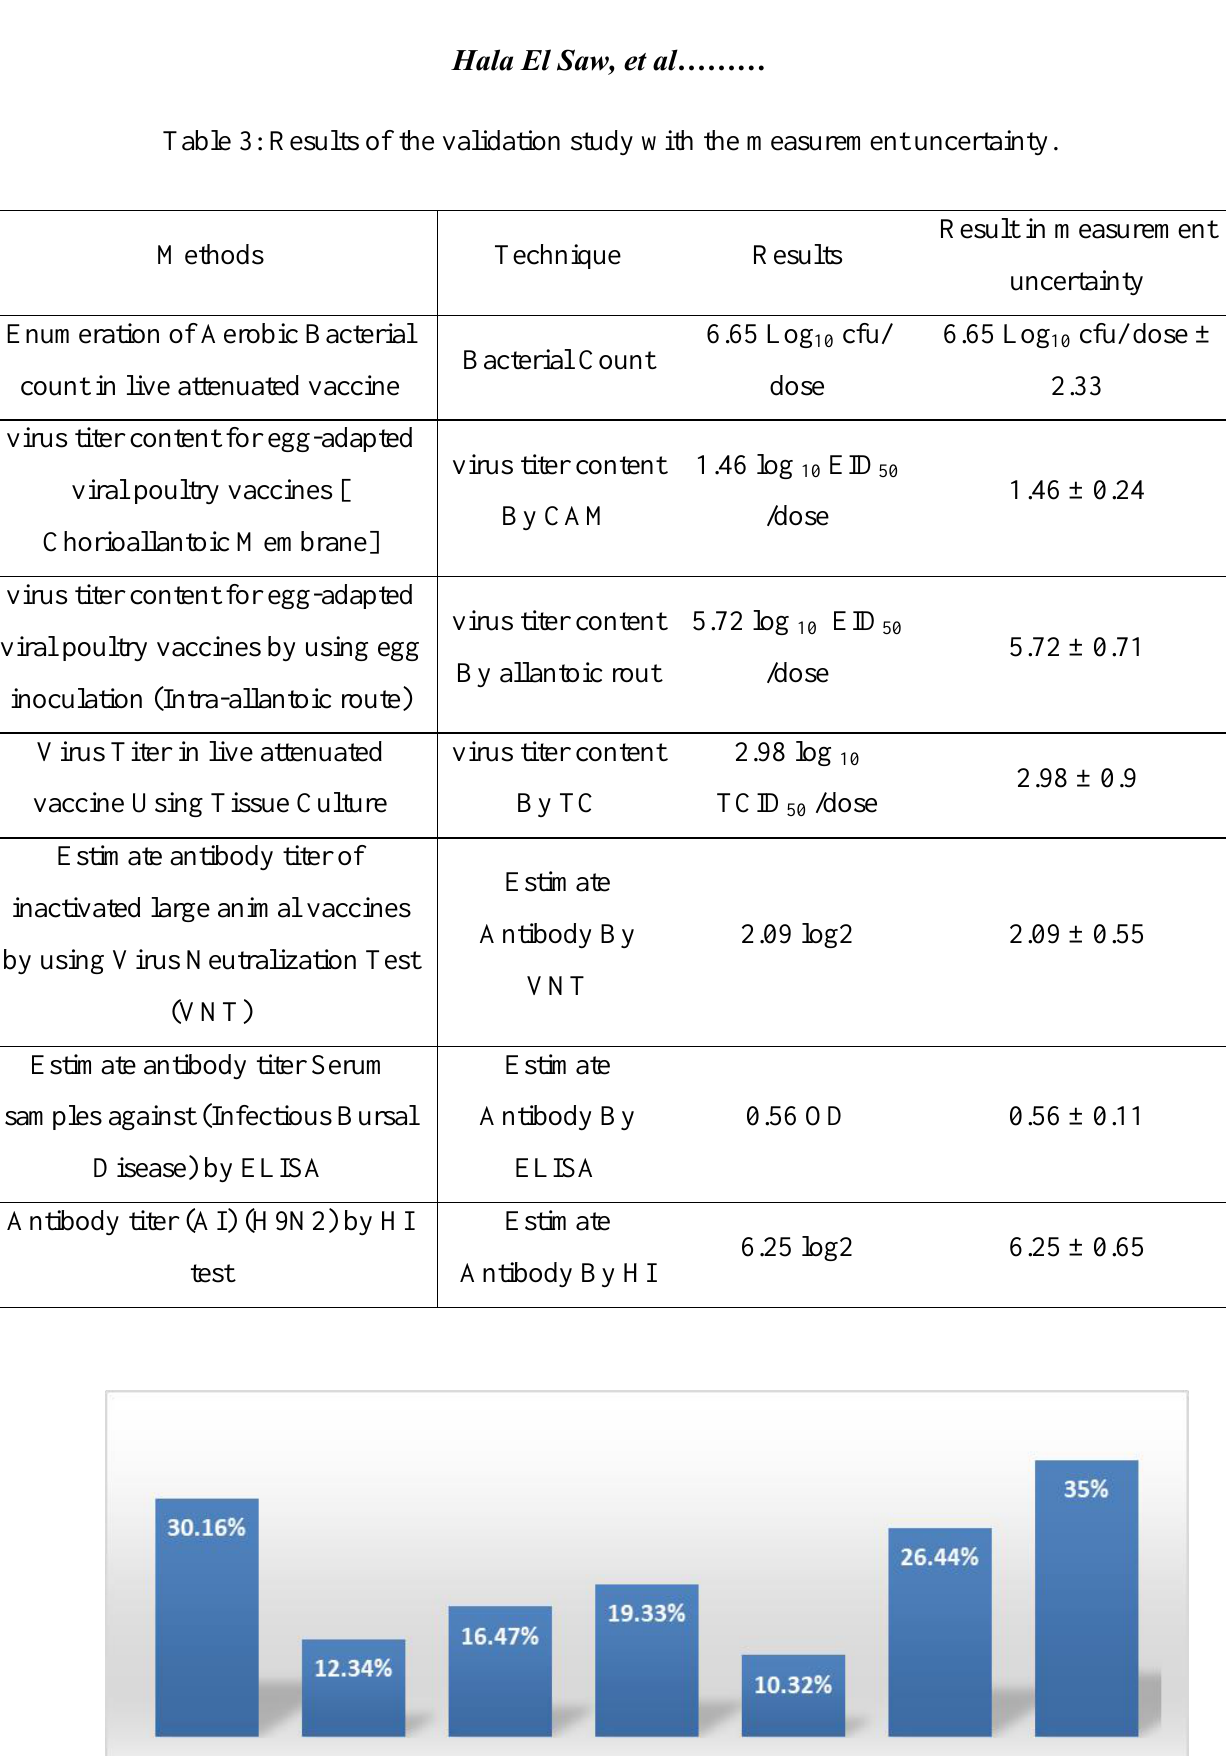
Table 3: Results of the validation study with the measurement uncertainty.